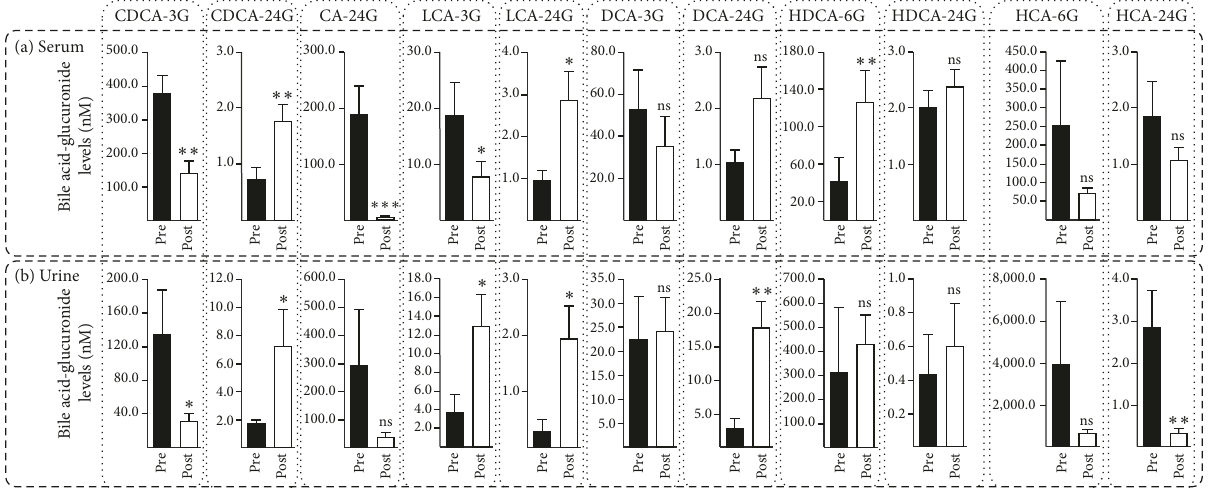
Figure 1: Endoscopic stenting of the bile duct differentially affects the serum (a) and urine (b) bile acid-glucuronide profiles in patients suffering from biliary obstruction. Serum ((a); 𝑛 = 17 ) and urine ((b); 𝑛 = 12 ) samples drawn before (pre) and after (post) endoscopic biliary stenting from patients with stenosed bile ducts were analyzed for their concentrations in 11 bile acid-glucuronide species using LC-MS/MS. Results represent the mean concentration ± SEM and are expressed as nM. 𝑝 values were determined by the Wilcoxon matched-pairs signed-rank test. ∗ 𝑝 < 0.05 ; ∗∗ 𝑝 < 0.01 ; ∗∗∗ 𝑝 < 0.001 . ns: not